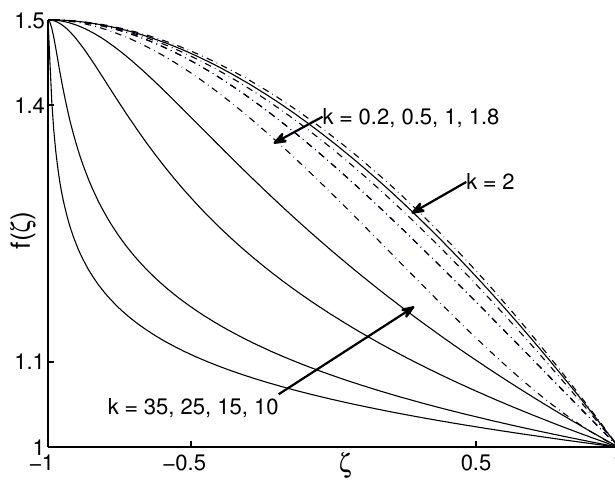
Figure 5. The graph of f ( ξ ) given by Equation (26) as k near 0.